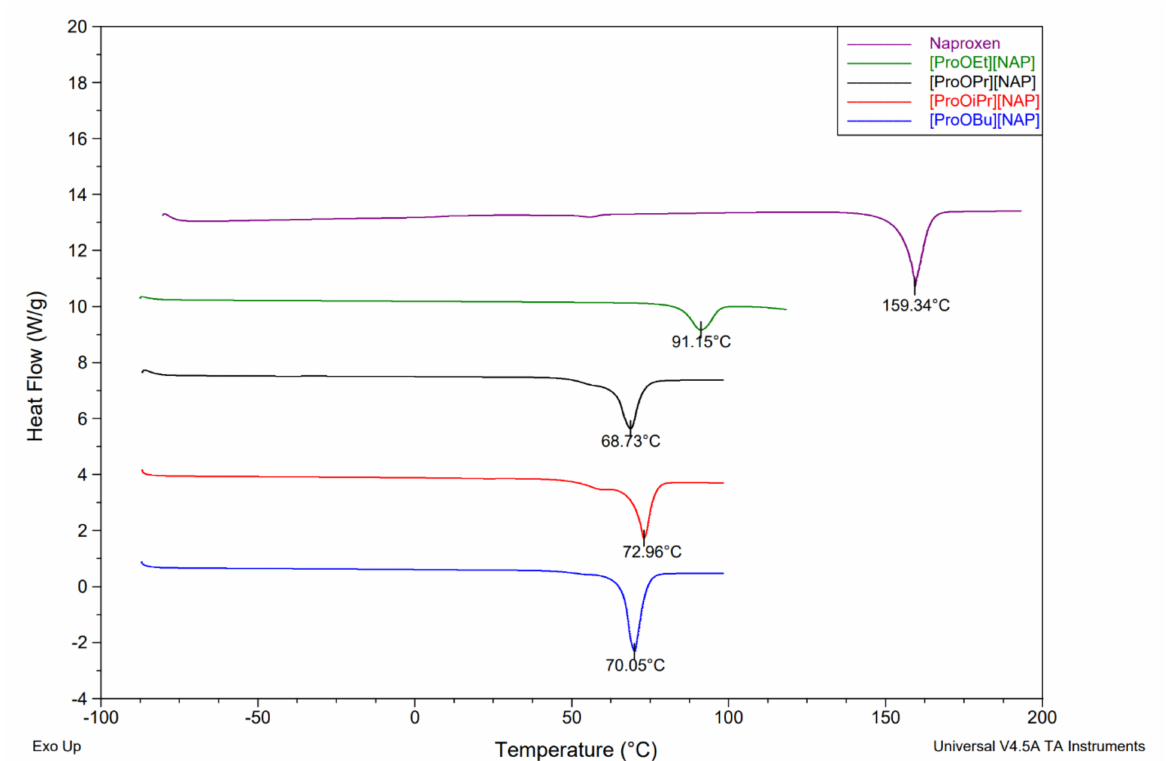
Figure 5. The DSC curves of naproxen (purple), L-proline alkyl ester naproxenates-[ProOEt][NAP] (green), [ProOPr][NAP] (black), [ProOiPr][NAP] (red), and [ProOBu][NAP]